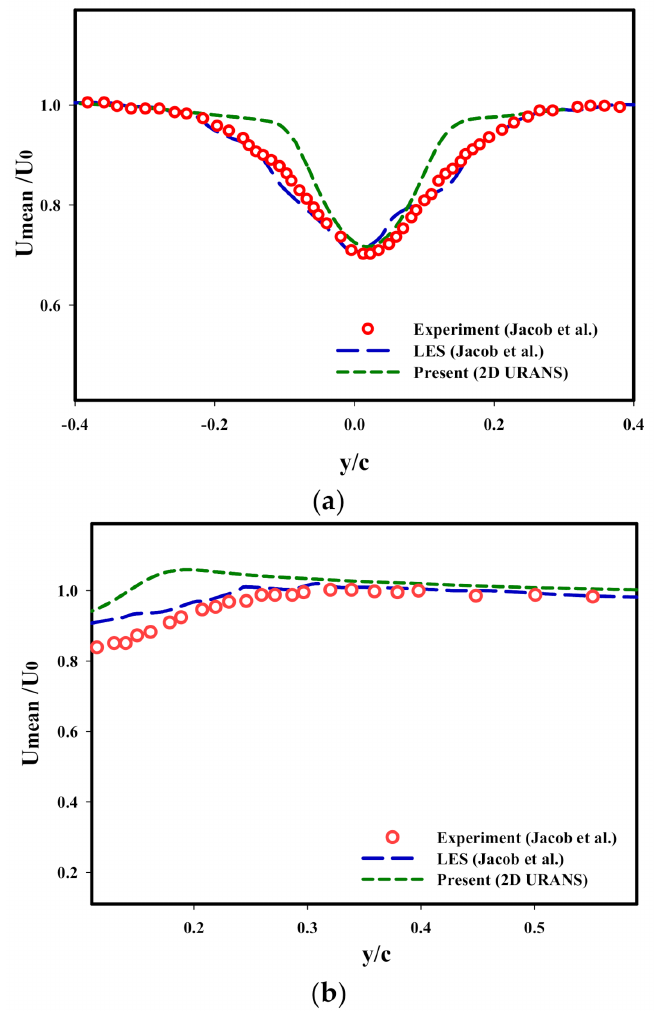
Figure 7. Diagram of the mean velocity validation based on [19]: ( a ) velocity profile at the wake zone at the downstream side of the rod (x/C = − 0.25), ( b ) velocity profile at the upper surface of the airfoil at (x/C = +